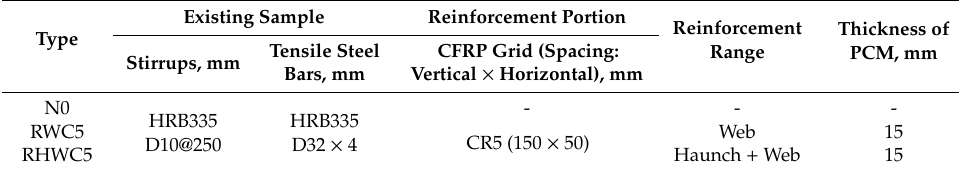
Table 1. Details of the beam specimens of Series A.